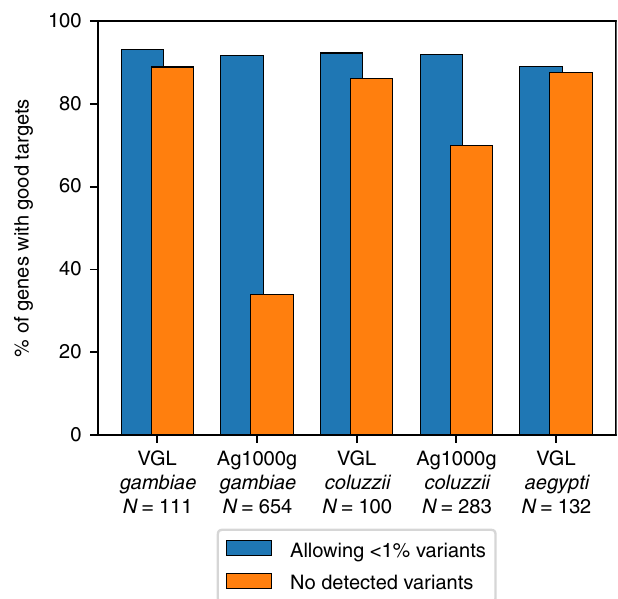
Fig. 2 Frequency of genes with good targets. The fraction of genes with good targets is dependent on the presence of low-frequency DRAs. When dismissing all targets with DRA frequencies > 0.0, the fraction of genes with good targets decreases with increasing sample size. Ignoring DRAs with frequencies below 1% in the dataset results in ~90% of genes having at least one good target in all datasets examined. VGL: Vector Genetics Laboratory, Ag1000G: The Anopheles gambiae 1000 Genomes Consortium.